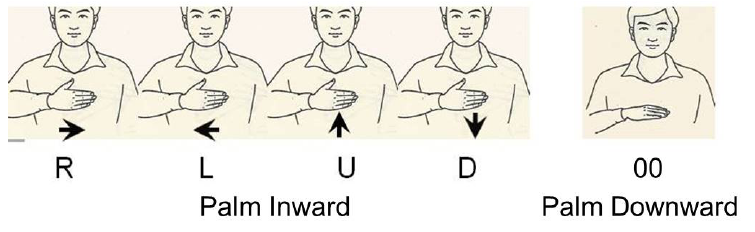
Figure 7. Illustration of the proposed trajectories and the default sign gestures